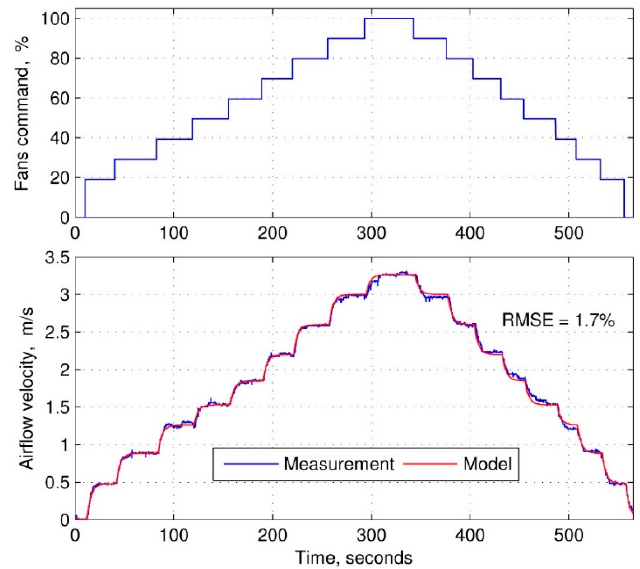
Figure 7. Measured and approximated airflow supplied by the test bench fans. RMSE: Root-mean-square error.